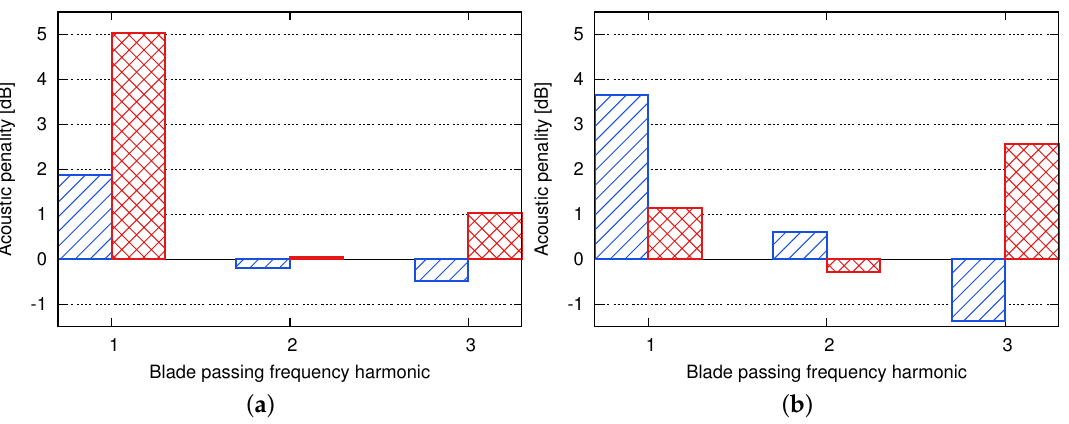
Figure 18. Acoustic penalty on each mechanism induced by the air-inlet distortion: penalty on the WSI mechanism in hatched blue bars and penalty on the DRI mechanism in crosshatched red bars. ( a ) Upstream; ( b )